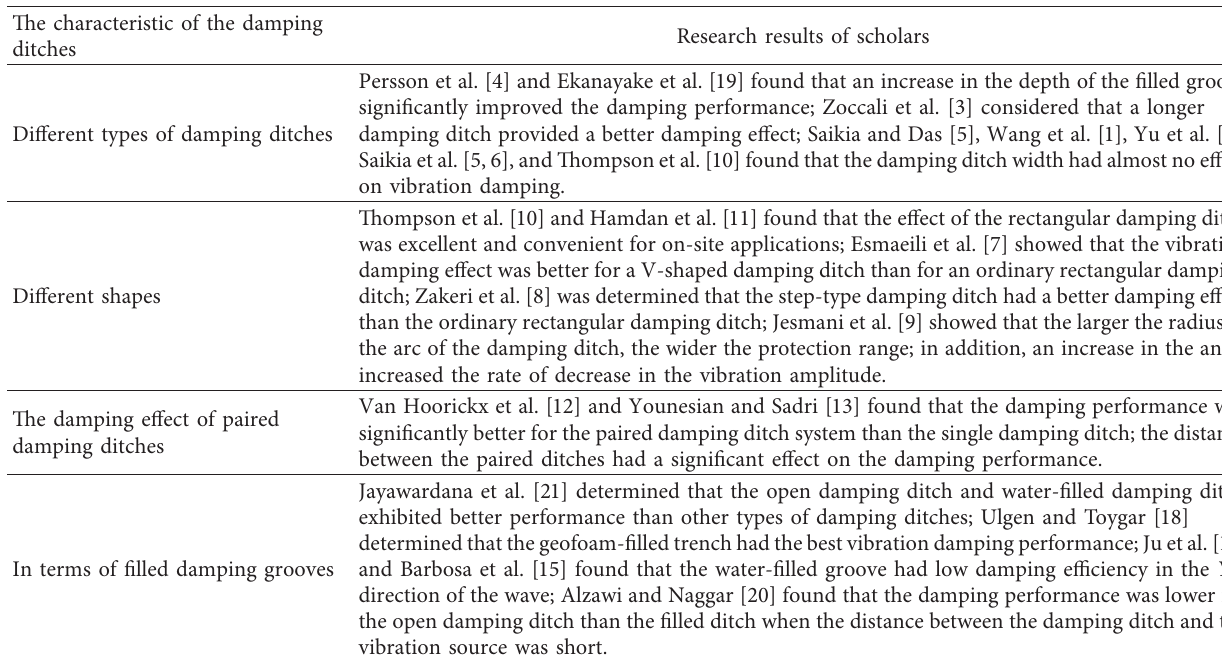
Table 1: Domestic and foreign scholars have conducted research on damping ditches for vibration reduction. The characteristic of the damping